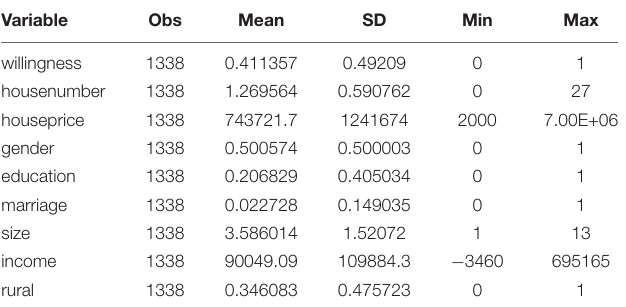
TABLE 2 | Descriptive statistics.